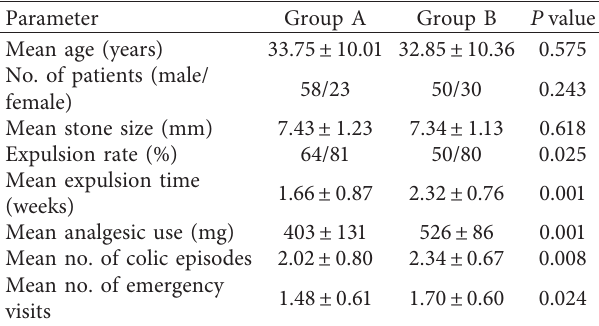
Table 2: Demographic and results.